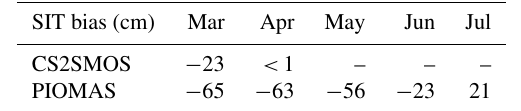
Table 2. Pattern correlations of monthly mean climatologies of SIT in TOPAZ4 with those in PIOMAS and CS2SMOS over the Arctic marginal seas (Laptev, East Siberian and Chukchi seas).